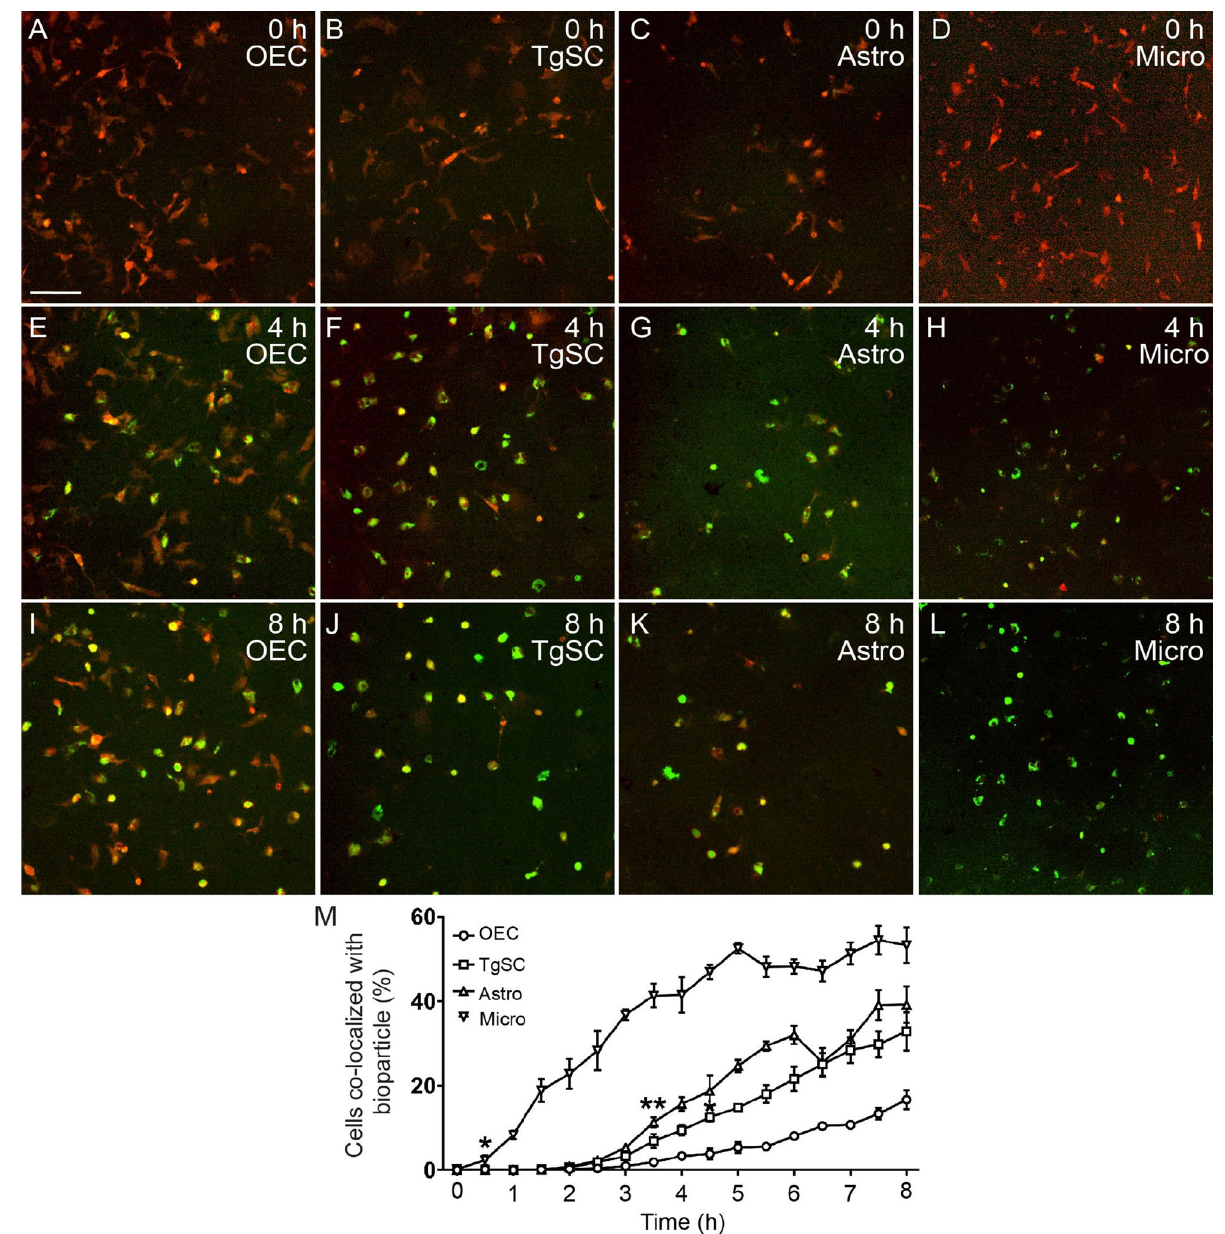
Figure 4. Phagocytosis of pHrodo S. aureus BioParticles by different glial cell types. ( A – L ) Images show fluorescent S. aureus BioParticles (which exhibit green fluorescence when inside lysosomes) co-localized with the glia (red; primary cultures from S100β-DsRed mice) at 4 h and 8 h post exposure. Since this is a live-cell assay, astrocytes (Astro) and microglia (micro) could not be immunolabeled and had to be identified based on their (weak) expression of DsRed. ( M ) Time-course of phagocytosis assay showing the percentage of glia that contained phagocytosed fluorescent S. aureus BioParticles at different time-points. Significant difference was observed at 30 min between micro and other glial cells, 3.5 h between Astro and OEC, at 4.5 h between TgSC and OEC. Data show mean ± SEM, * p ≤ 0.05, ** p ≤ 0.01, two-way ANOVA with Tukey’s multiple comparison test, n = 3 biological replicates × 4000 cells per well. Scale bar: 100